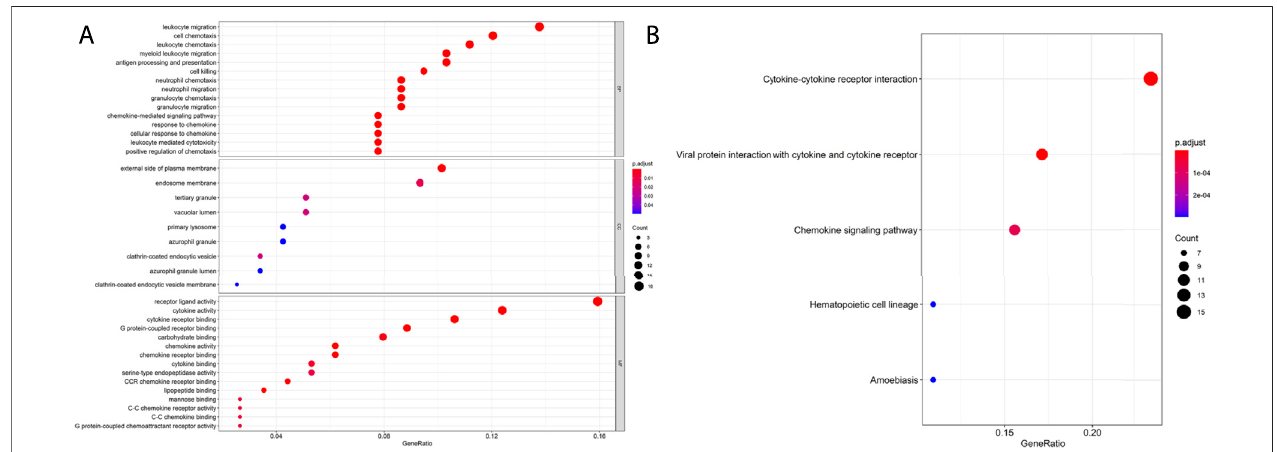
FIGURE 5 | GO and KEGG enrichment analysis of blue module genes. (A) GO enrichment of the blue module gene. (B) KEGG pathway analysis of the blue module gene.